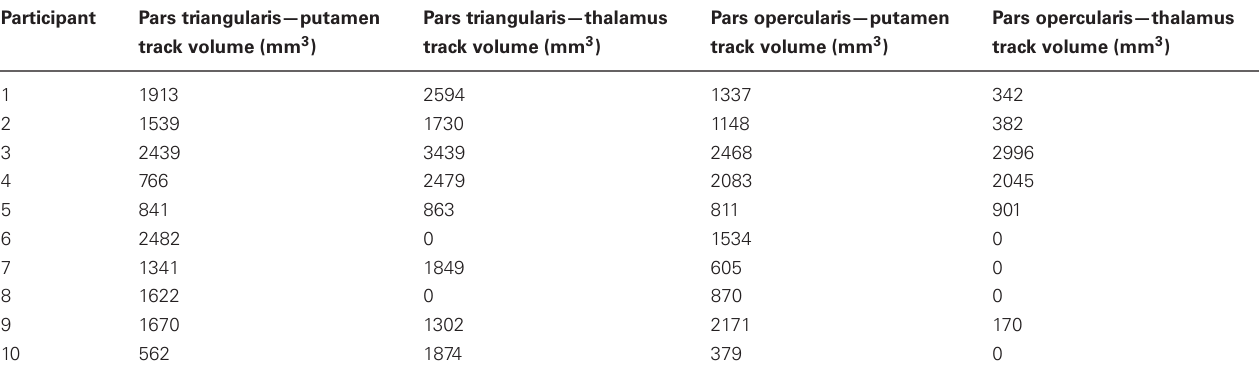
Table 1 | Inferred track volumes for pathways connecting Broca’s area, putamen, and thalamus. Participant Pars triangularis—putamen Pars triangularis—thalamus Pars opercularis—putamen Pars